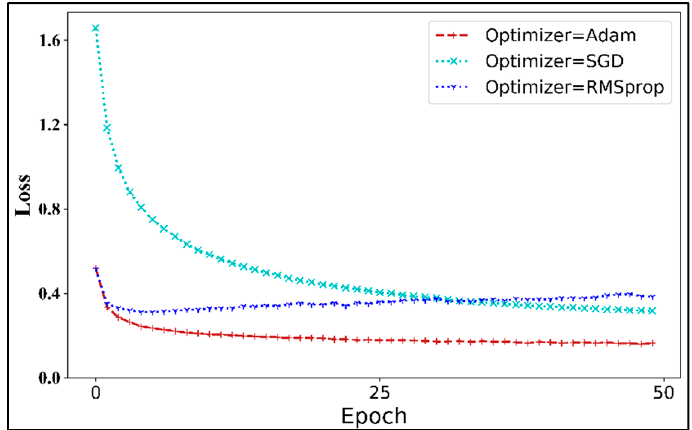
Figure 6. Convergence error of cost function for three types of optimizer.